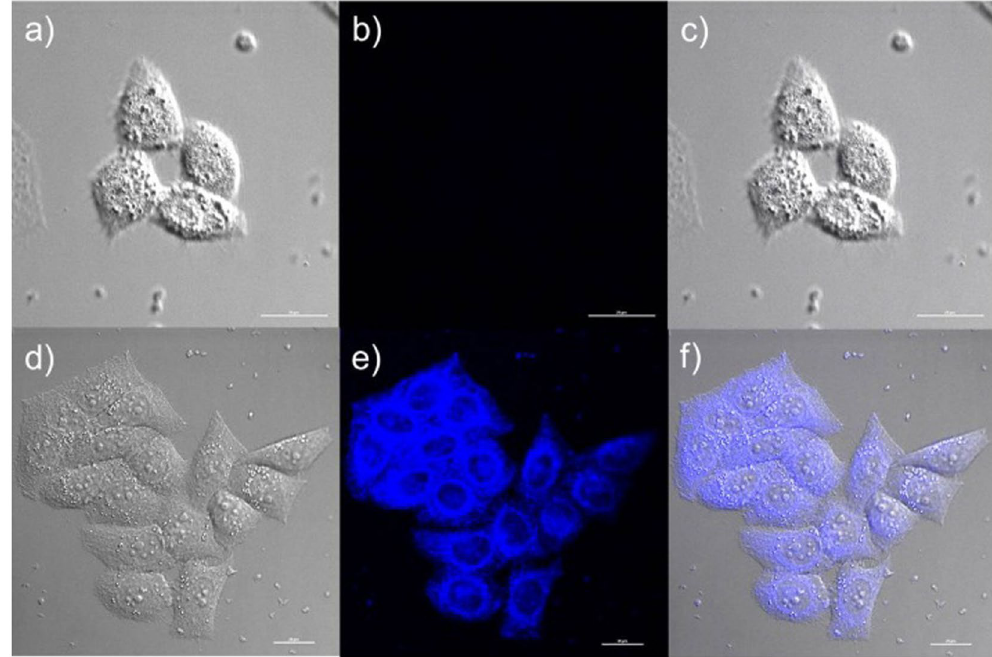
Figure 8. Brightfield and fluorescence images of HeLa cells stained with the probe NS-N 2 H 4 . ( a ) Brightfield image of HeLa cells costained only with NS-N 2 H 4 ; ( b ) Fluorescence images of ( a ) from blue channel; ( c ) overlay of ( a and b ); ( d ) Brightfield image of HeLa cells costained with NS-N 2 H 4 and treated with N 2 H 4 ; ( e ) Fluorescence images of ( d ) from blue channel; ( f ) overlay of the brightfield image ( d ) and blue channels ( e